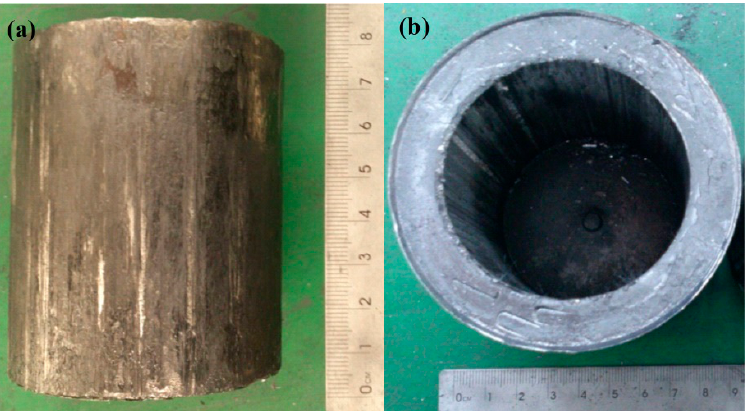
Figure 3. Macrographs of the thixoformed part of the nano-sized SiCp/7075 composite: ( a ) front view and ( b ) top view.